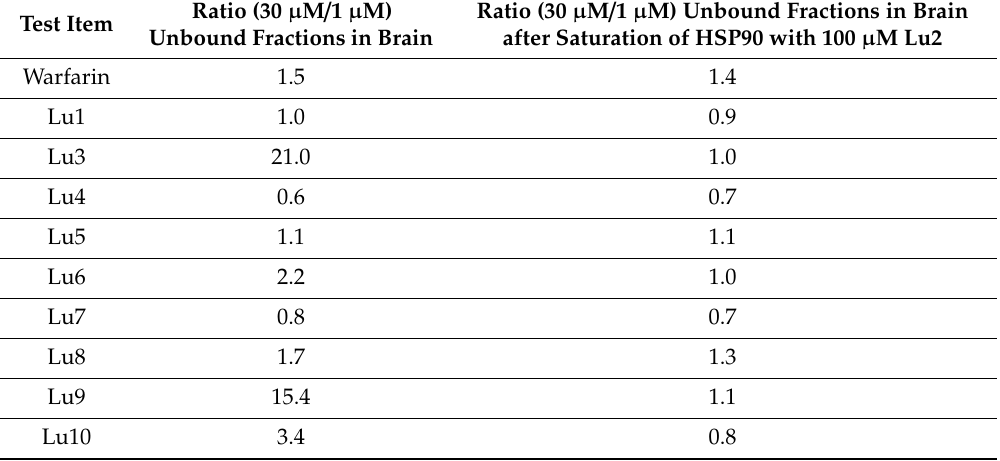
Table 3. E ff ect of HSP90 saturation with 100 µ M of Lu2 on the concentration-dependent change in binding to brain tissues for HSP90 inhibitors.